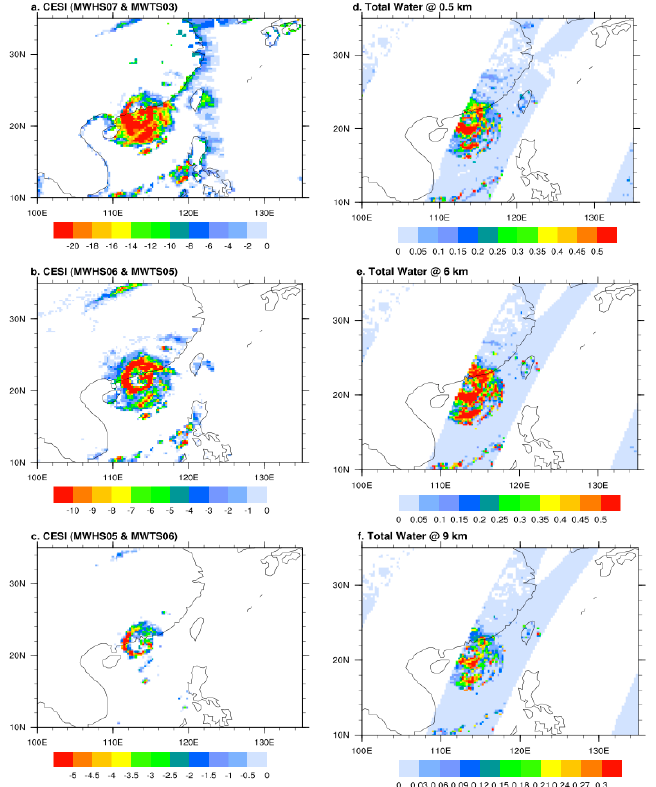
Figure 6. Spatial distributions of CESIs derived from ( a ) CESI low , ( b ) CESI mid and ( c ) CESI high on 16 September 2018. The spatial distributions of GPM total water product are shown at ( d ) 0.5 km, ( e ) 6 km and ( f ) 9 km.